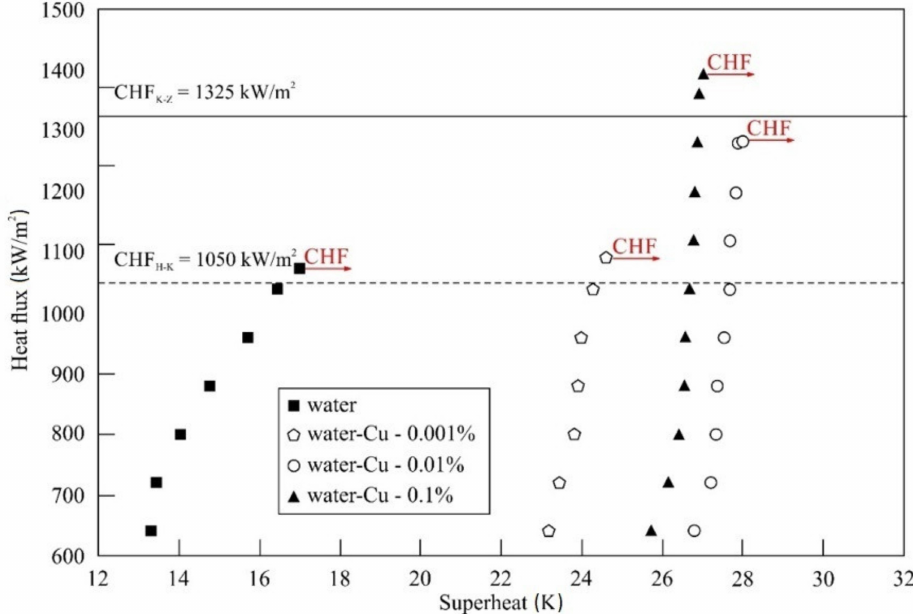
Figure 9. Boiling curves and CHF for water–Cu nanofluids.